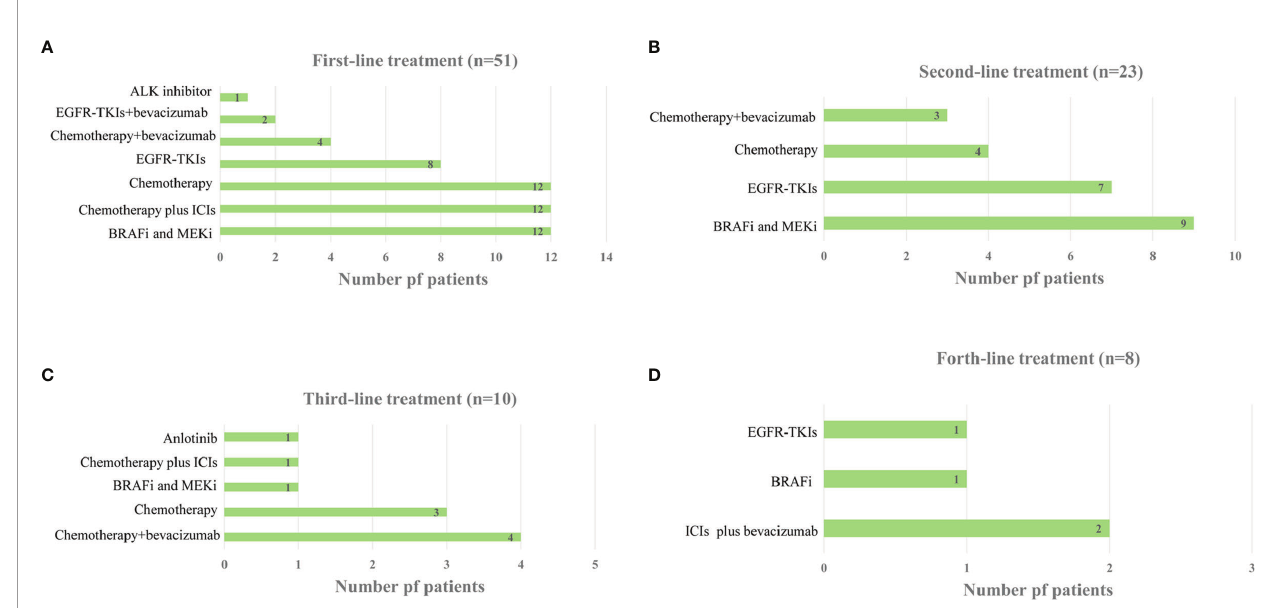
FIGURE 1 | (A) Distribution of Systemic Treatment Regimens in the fi rst-line Setting. (B) Distribution of Systemic Treatment Regimens in the second-line Setting. (C) Distribution of Systemic Treatment Regimens in the third-line Setting. (D) Distribution of Systemic Treatment Regimens in the forth-line